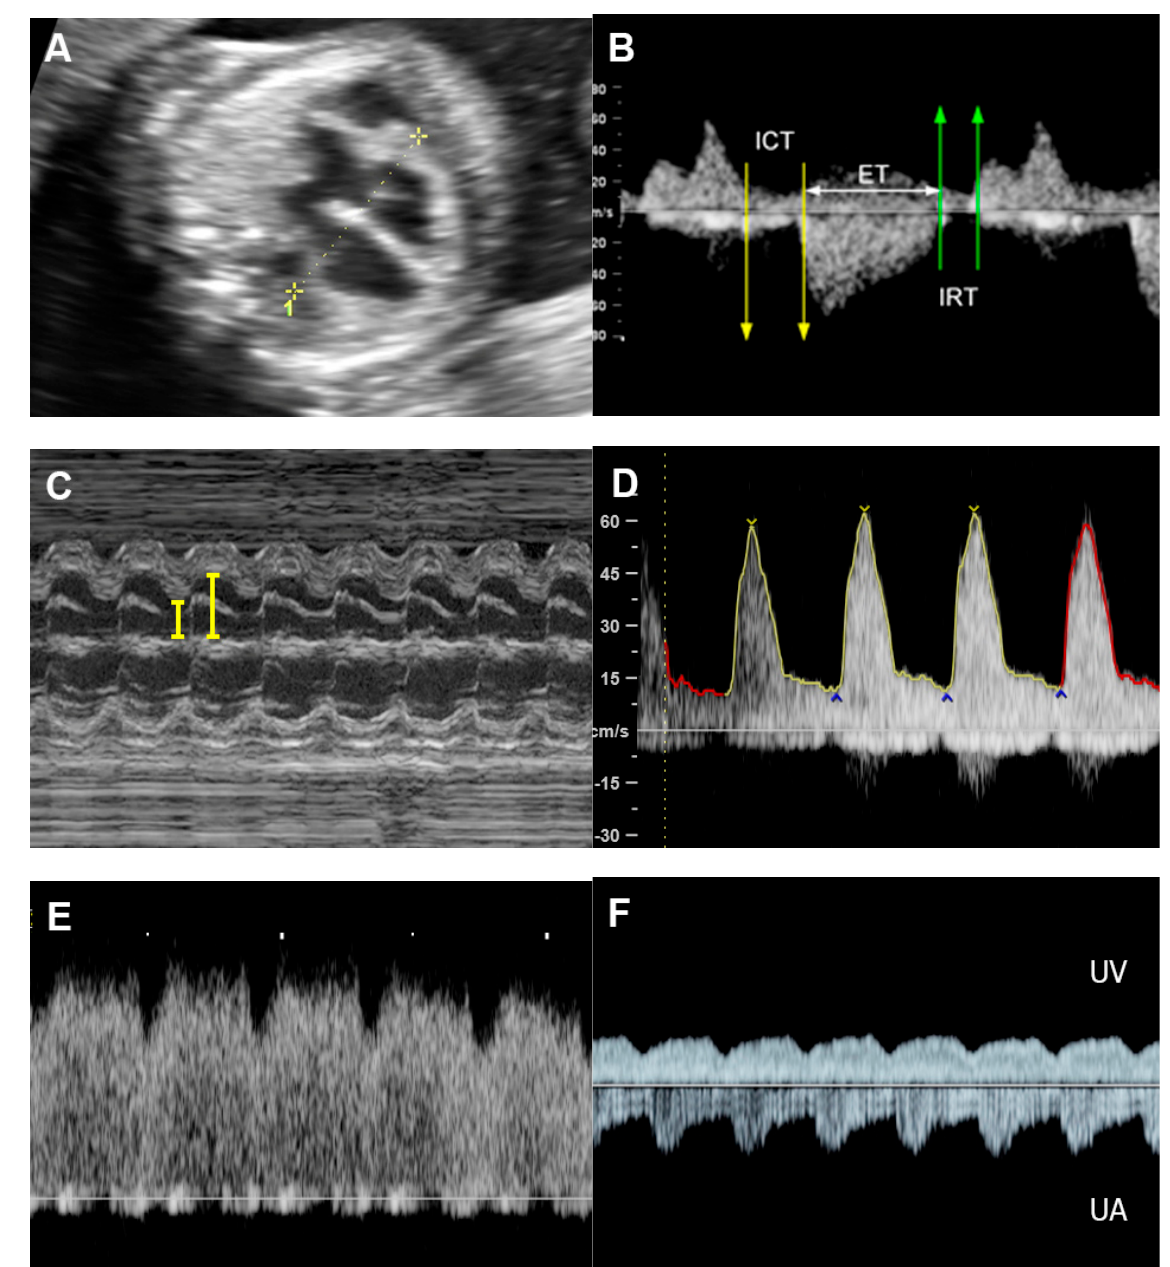
Figure 4. Hydrops without heart failure in Hb Bart’s disease: ( A ) cardiomegaly with effusions; ( B ) slightly increased Tei index (0.49) with prolonged ICT (42 ms); ( C ) normal shortening fraction 38%; ( D ) High MCA-PSV (60 cm/s); ( E ) markedly increased forward A-wave of the ductus venosus; ( F ) normal Doppler waveforms in the umbilical artery (UA) but pulsations in the umbilical vein (UV). We previously pointed out that based on our extensive experience in fetal anemia Increased Afterload secondary to Hb Bart’s disease, fetal hemodynamic response to anemia is consistent with Increased ventricular afterload can eventually result in FHF, when compensatory mechanisms become exhausted. The causes of increased afterload are as follows: (1) blood flow obstruction in the heart, such as aortic stenosis, pulmonary stenosis, restrictive foramen ovale and constriction of the ductus arteriosus. (2) Extra-cardiac causes, including increased systemic vascular resistance caused by placental insufficiency as commonly seen in fetal growth restriction and twin-twin transfusion syndrome